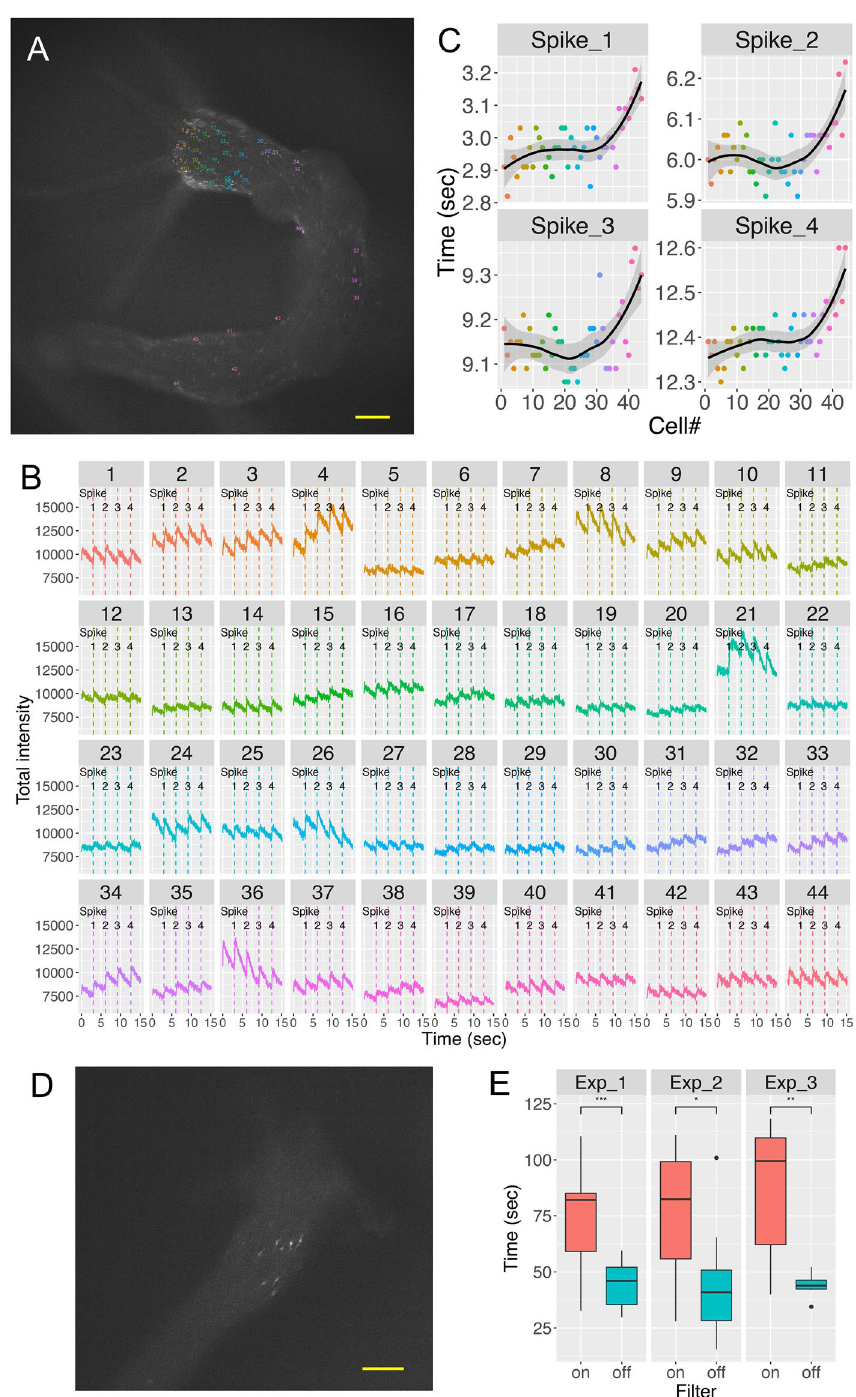
Figure 5. Unidirectional signal transmission in the body neuron circuit. Hym-176B::GCaMP transgenic animal was treated with procaine. Tested neurons are numbered according to their position, ascending from head to foot (cell#) ( A ). Neuronal activity (total intensity of GCaMP) with vertical lines indicating individual excitation spikes of each neuron ( B ). For each spike, the starting time is plotted against the cell# ( C ). The number in each strip, the color of the excitation profile in B, and the color of dots in C correspond to cells in A. The solid black line indicates loess regression with the 95% confidence interval in gray. Light-activated neurons in Hym-176B::GCaMP transgenic animal ( D ). Bar: 100 µm both in A and D. Box plot of time, which was taken by light-activated neurons to start excitation when exposed to blue light with or without dark filter ( E ). Three independent experiments were conducted (n = 22 for exp_1 and 2, and n = 14 for exp_3). Statistical significance of the difference between the average time to the beginning of excitation with and without a dark filter was evaluated using two-sided Student’s t-test; NS: no significant difference; *p < 0.05; **p < 0.01; ***p <